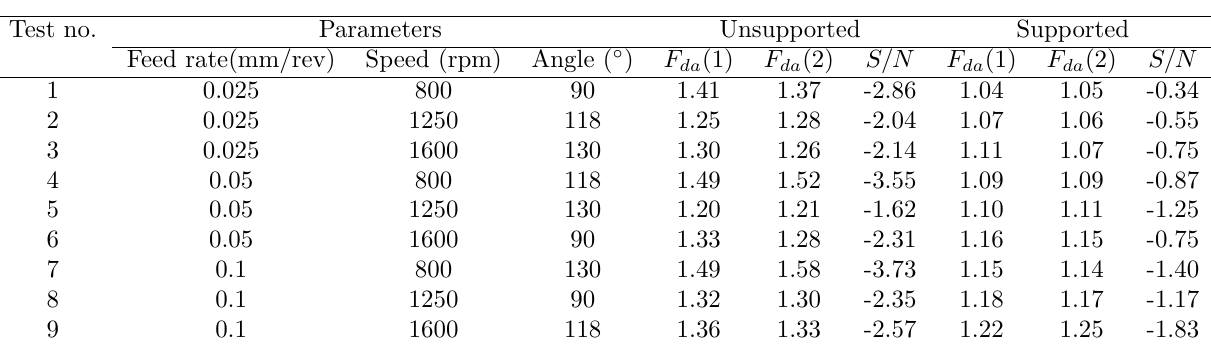
Table 1. L orthogonal array of Taguchi and experimental results. 9